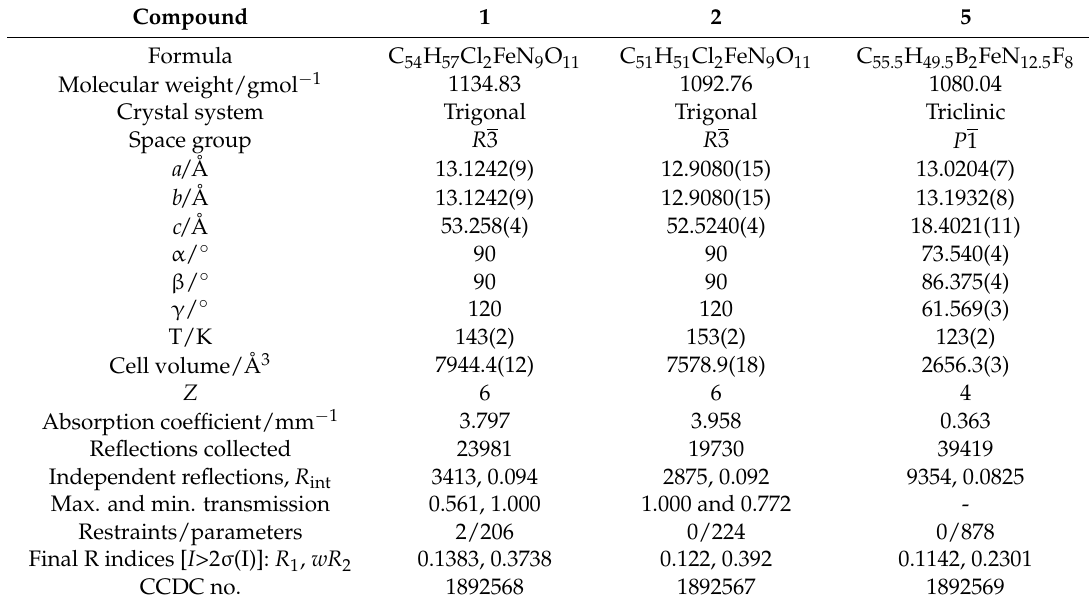
Table 1. Crystallographic data and structure refinement for 1 , 2 and 5